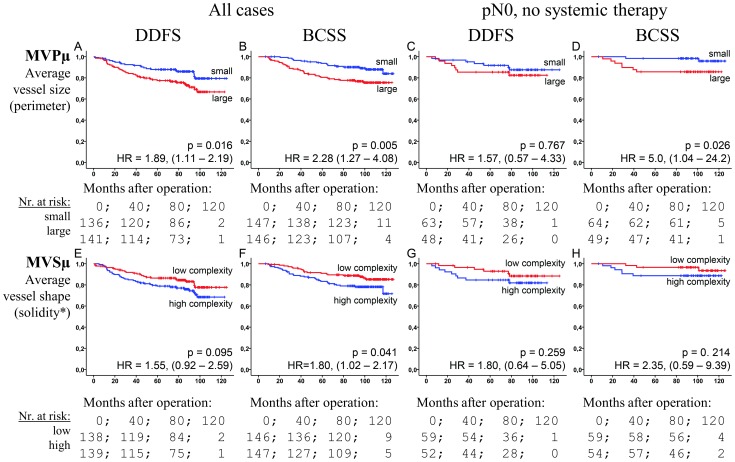
The prognostic associations of the dichotomized markers.The Kaplan-Meier plots of the median-categorized MVPμ (A–D) and MVSμ (E–H) data against DDFS (A, C, E, G) and BCSS (B, D, F, H) end-points in the set of all cases (A,B,E,F) and the set of node-negative no systemic therapy cases (C,D,G,H). p-values are by the log-rank test. Hazard ratios (HR) with 95-% confidence intervals in parentheses are for Cox regression of high-risk vs low-risk groups. *: Low and high solidity corresponds, respectively, to high and low vessel profile complexity.